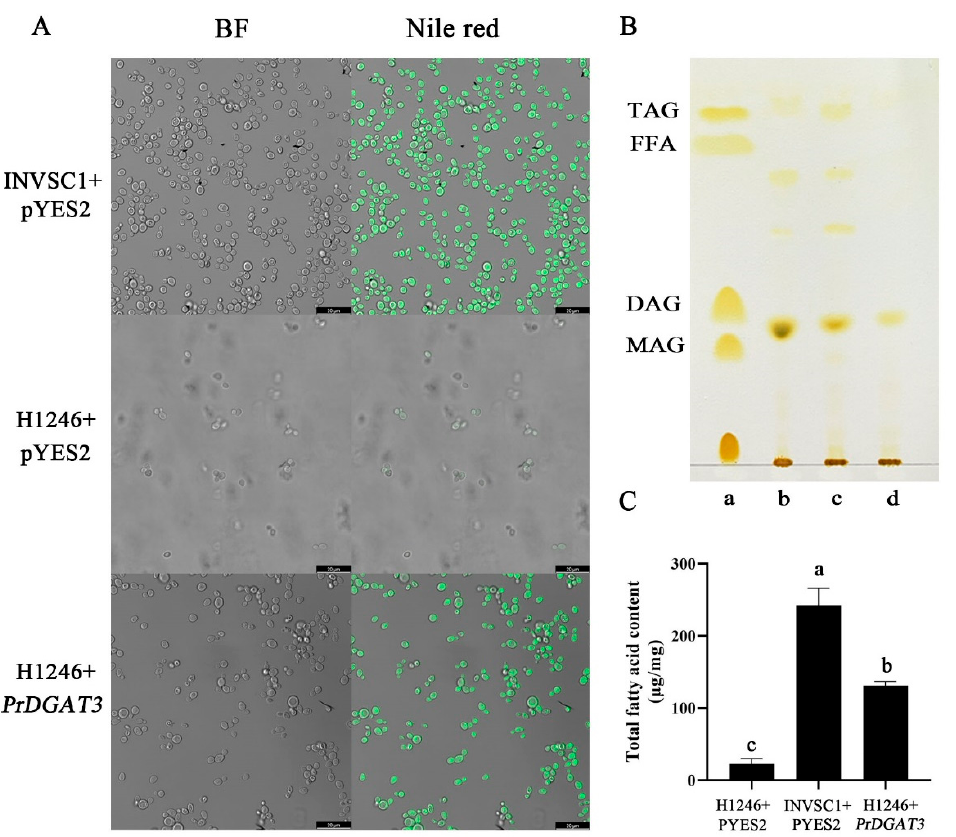
Figure 2. Functional verification of PrDGAT3 in yeast mutant H1246. ( A ) Oil body formation in yeast cells stained with Nile red and examined by confocal laser scanning microscope. Bars = 20 µm. ( B ) Evaluation of TAG biosynthesis in the transgenic yeast cells by thin-layer chromatography (TLC). Lane a, standards of acyl-lipid classes: TAG (triacylglycerol), FFA (free fatty acids), DAG (diacylglycerols), and MAG (monoacylglycerol). Lane b, neutral lipids from yeast mutant H1246 cells expressing PrDGAT3 . Neutral lipids from yeast mutant H1246 cells harboring the empty vector (pYES2) (negative controls). Lane c, neutral lipids from the wild-type yeast cells (positive controls). Lane d, neutral lipids from yeast mutant H1246 cells harboring the empty vector (pYES2) (negative controls). ( C ) Total fatty acid content (% dry weight). Values are mean ± SD ( n = 3). Different letters indicate significant difference at p < 0.05, as confirmed by one-way ANOVA with Tukey’s post hoc